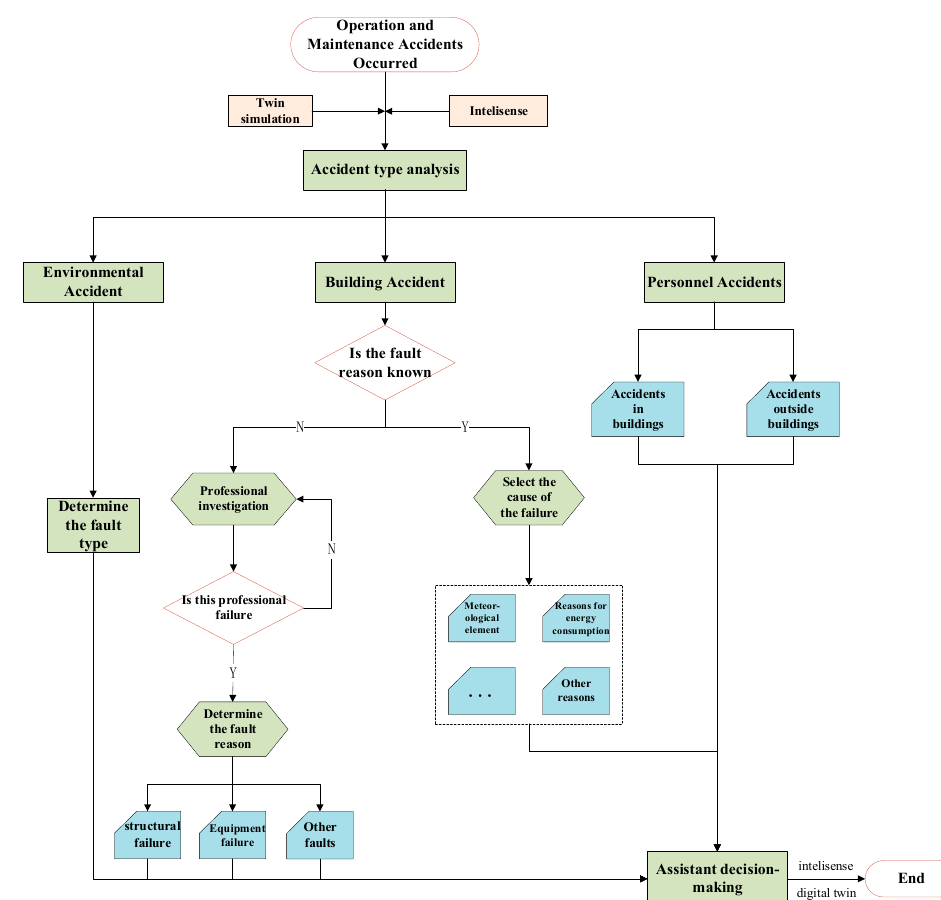
Figure 7. Management process of building O&M accidents based on GNSS–DTs.